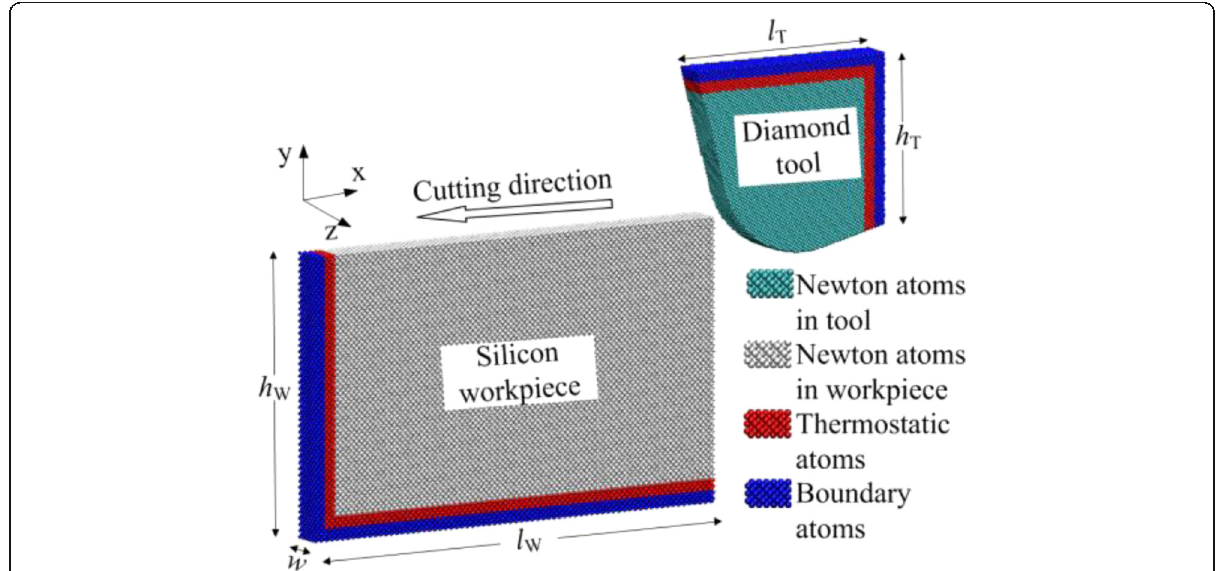
Fig. 1 Schematic diagram of MD simulation model for nanometric